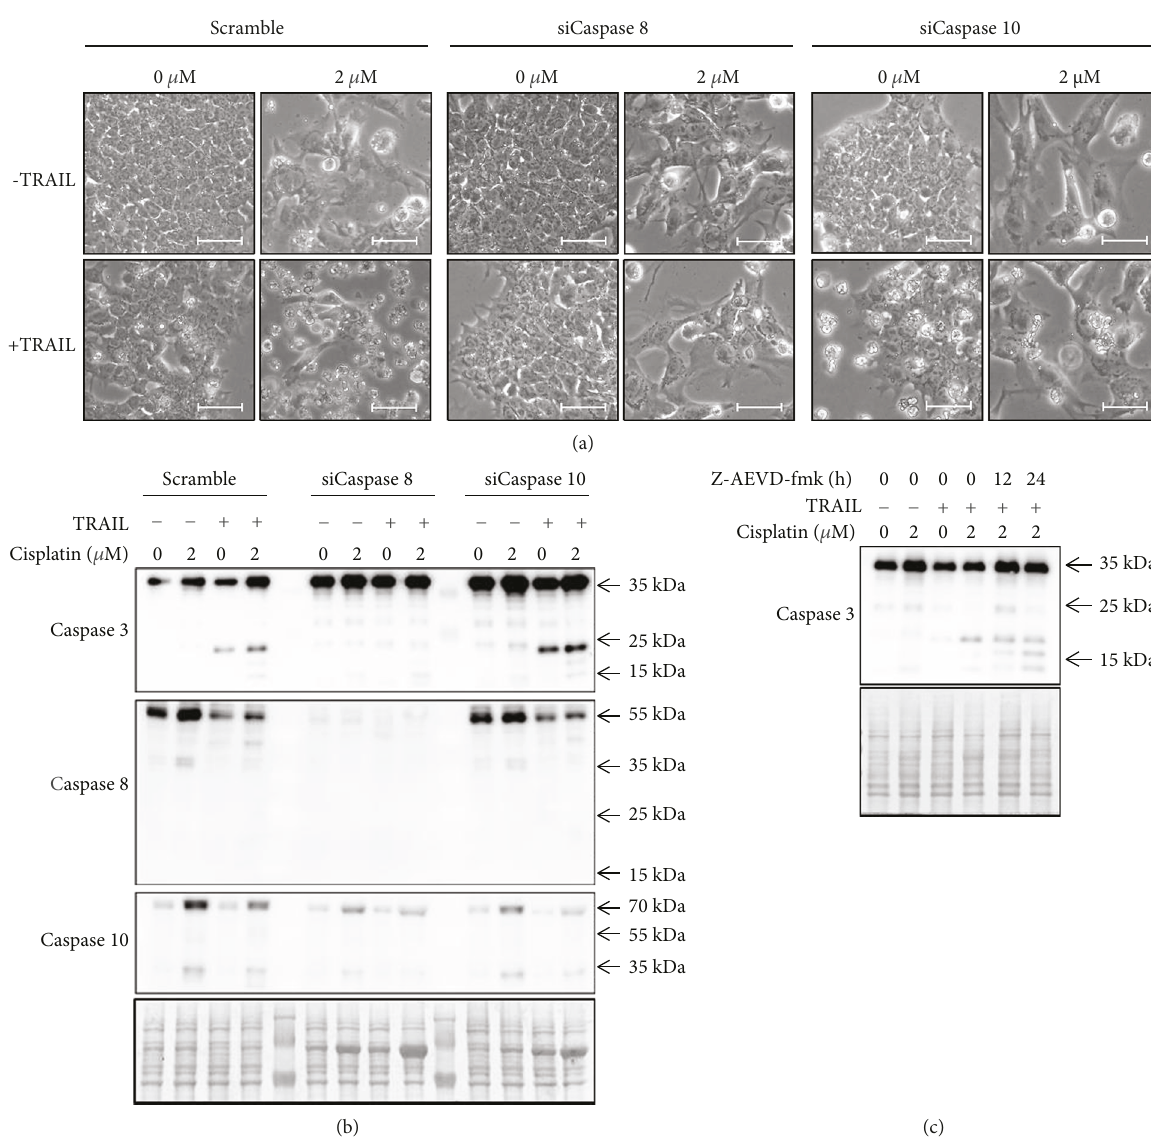
Figure 4: Downregulation of caspase 8 abolishes apoptosis induced by cisplatin and TRAIL. (a) Morphology of hESC upon siRNA-mediated knockdown of caspases 8 and 10, respectively, followed by combined cisplatin and TRAIL treatment, as observed by light microscopy (10x, bar 50 μ m). (b) Activation of the caspase cascade upon the given treatments are demonstrated by western blot visualization of the